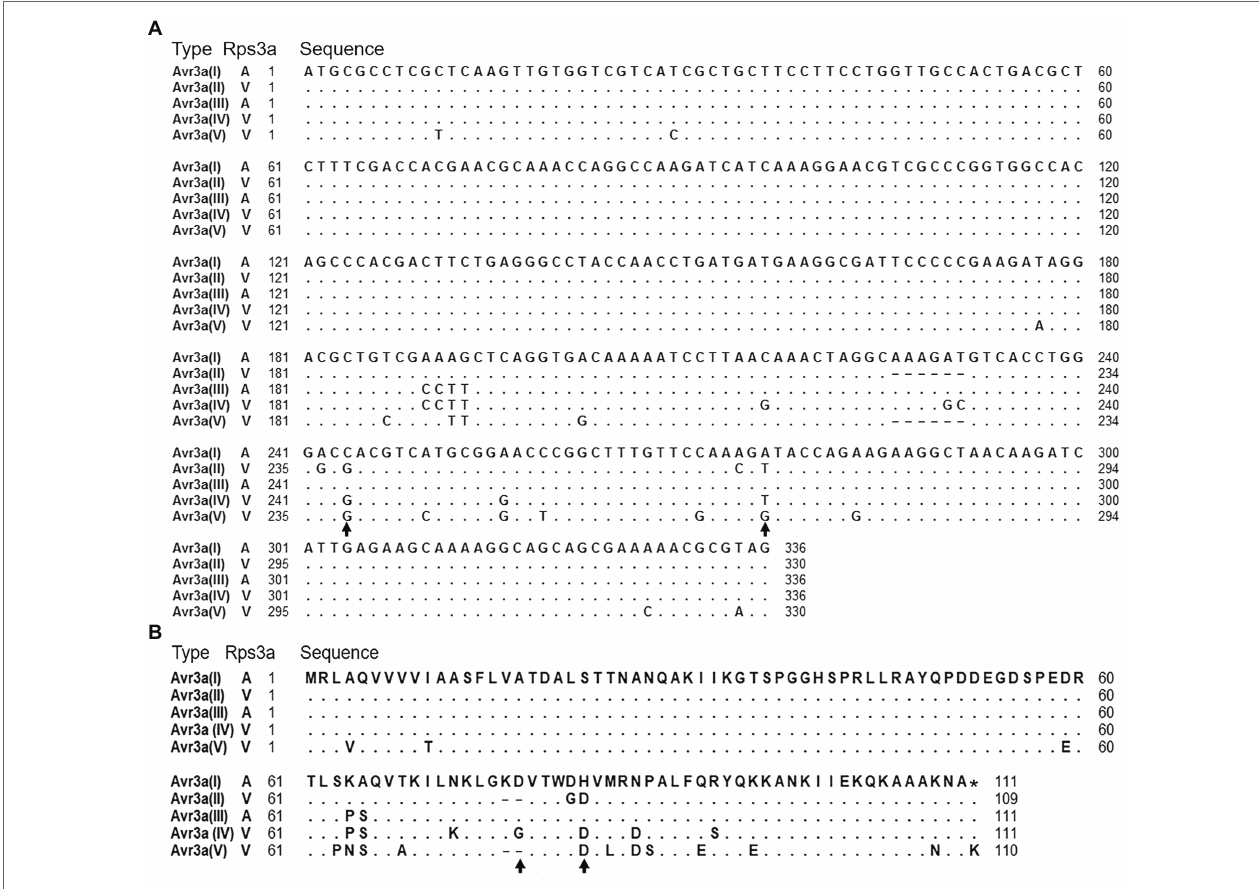
FIGURE 1 | Sequence comparison of five Avr3a alleles. (A) Comparison of nucleotide sequences. Identities are indicated by dots and substitutions by the substituted nucleotides. Black arrows denote two nucleotides, which were different between avirulent alleles and virulent alleles. (B) Comparison of amino acid sequences. Black arrows denote two amino acids, which were different between avirulent alleles and virulent alleles.